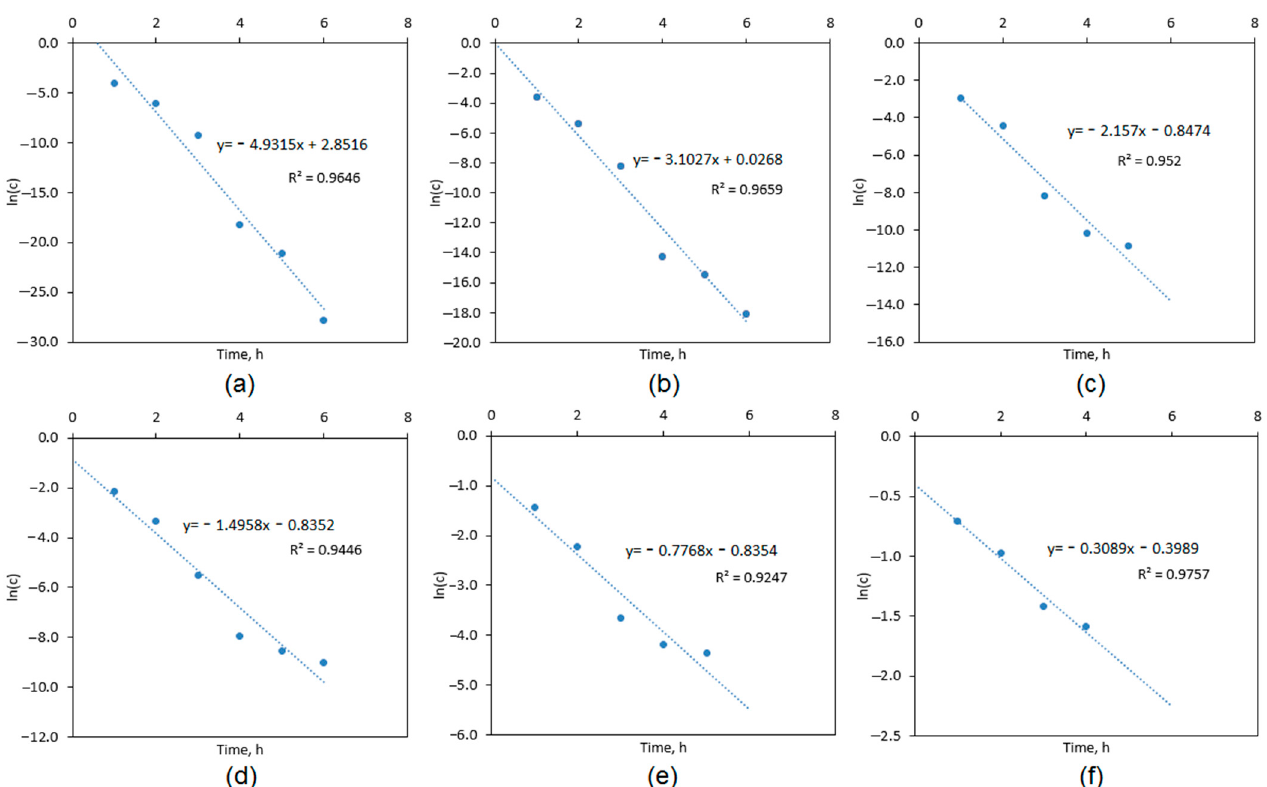
Figure 12. Cannabidiol release kinetics study: ( a ) hydrogel; ( b ) CS-ZnO-1; ( c ) CS-ZnO-2; ( d ) CS-ZnO-3; ( e ) CS-ZnO-4; and ( f ) CS-ZnO-5 .